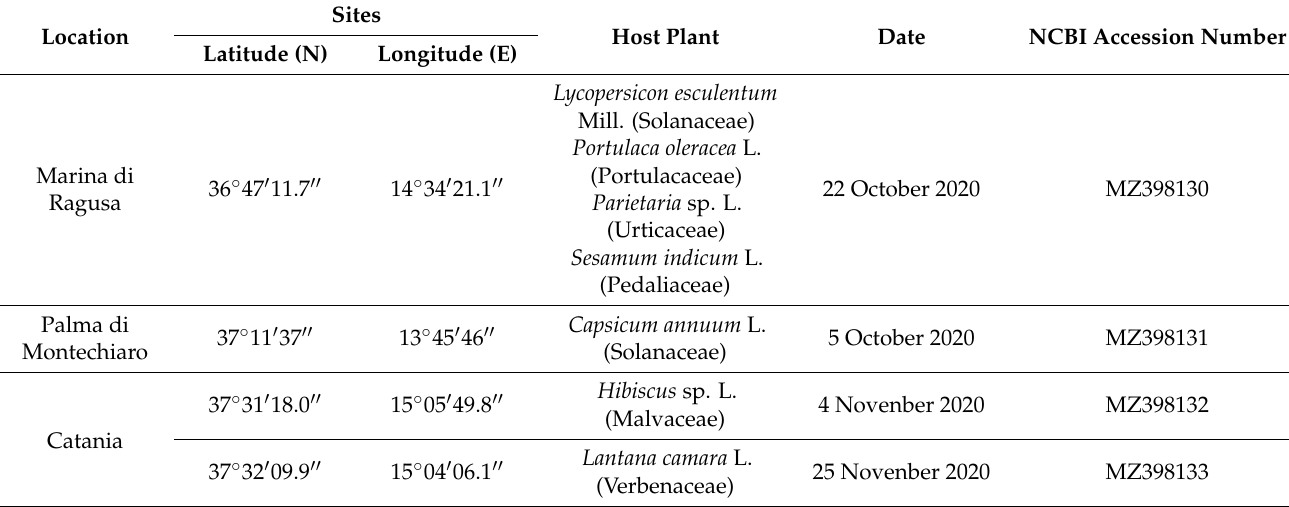
Table 1. Location, sites, and host plants where Phenacoccus solenopsis was found in Sicily between October and